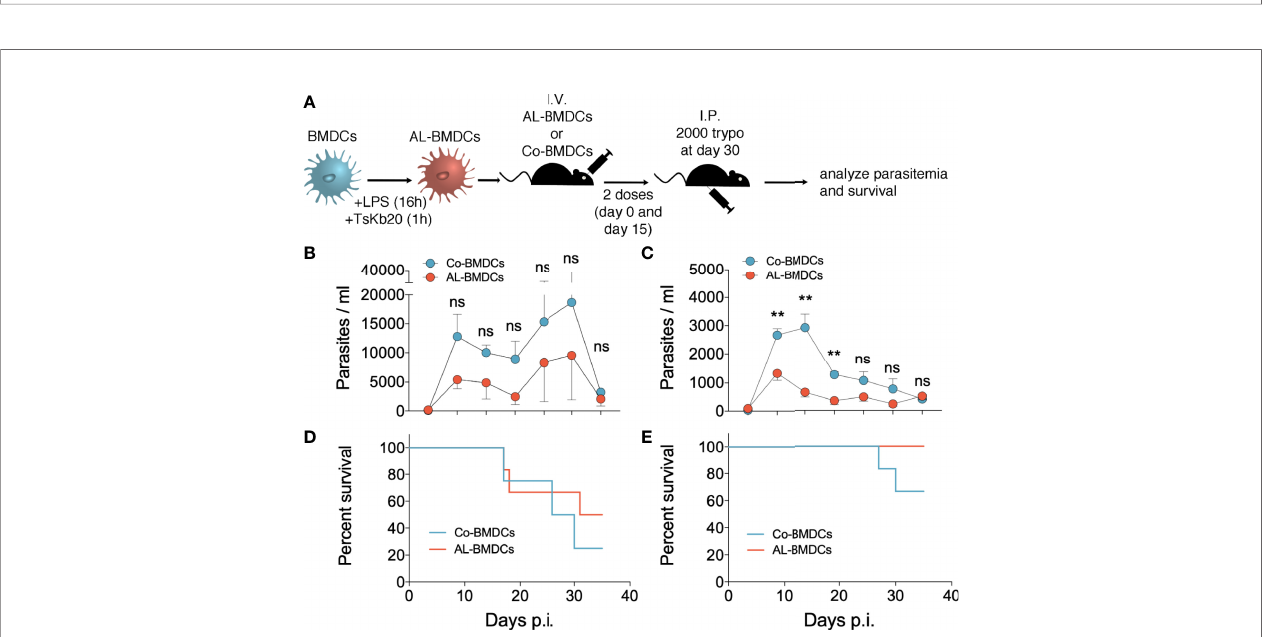
FIGURE 4 | Parasitemia and survival of mice immunized and infected with T. cruzi. (A) Immunization and infection scheme. Parasitemia represented as parasites per 50 fi elds of male (B) and female (C) mice immunized with AL-BMDCs or Co-BMDCs and infected with 2000 T. cruzi blood trypomastigotes. Mean + SEM is shown [for (B) n = 6 for mice immunized with AL-BMDCs and n = 4 for mice immunized with Co-BMDCs, for (C) n = 6 per group, Mann-Whitney test, p-values = 0.0022 10 days post infection (dpi), 0.0065 17 dpi, 0.0043 21 dpi (C) ]. Survival plot of male (D) and female (E) mice immunized with AL-BMDCs (red) or Co-BMDCs (blue) and infected [for (D) n = 6 for mice immunized with AL-BMDCs and n = 4 for mice immunized with Co-BMDCs, for (E) n = 6 per group, log-rank [Mantel-Cox) test, p- values = 0.4470 (D) , 0.1761 (E)